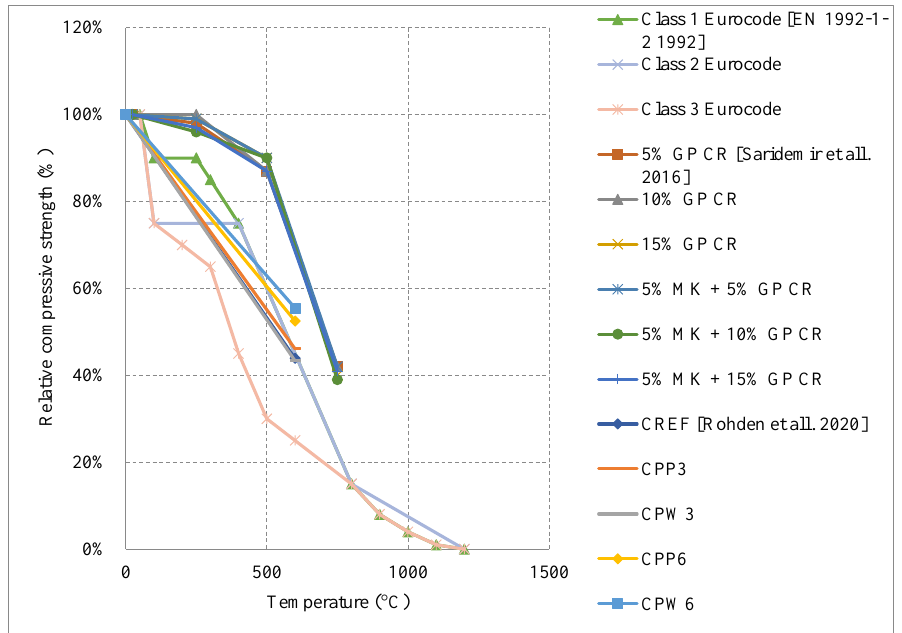
Figure 14. Relative compressive strength of naturally cooled HSC with different constituents. MK: Metakaolin, GP: Ground Pumice, CR: Cement Replacement, CPP3: Concrete with 3 kg/m 3 Polypropylene fibers, CPP6: Concrete with 6 kg/m 3 Polypropylene fibers, CPW3: Concrete with 3 kg/m 3 Plastic Waste, CPW6: Concrete with 6 kg/m 3 Plastic Waste [5,68,77].